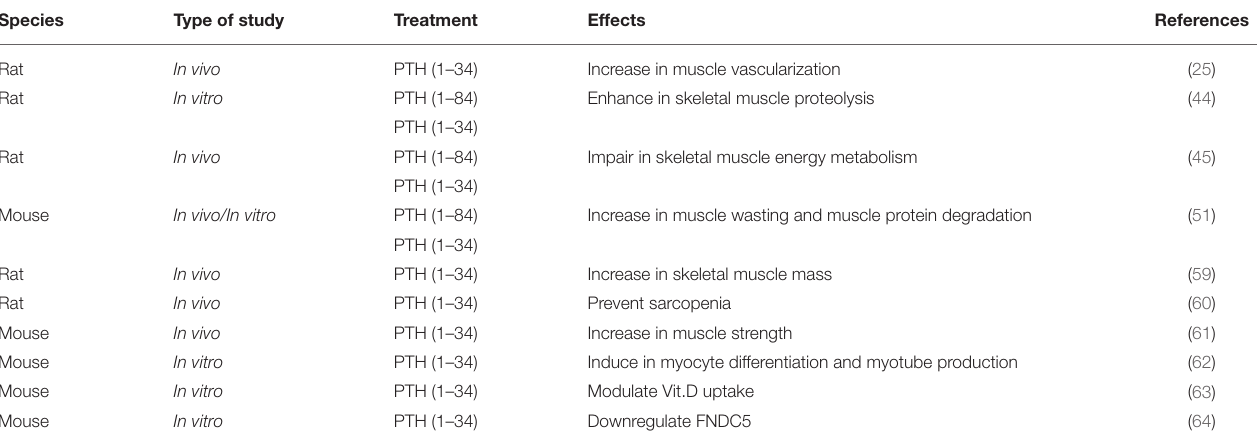
TABLE 1 | Studies on the effects of PTH on skeletal muscle in in vivo/in vitro models.